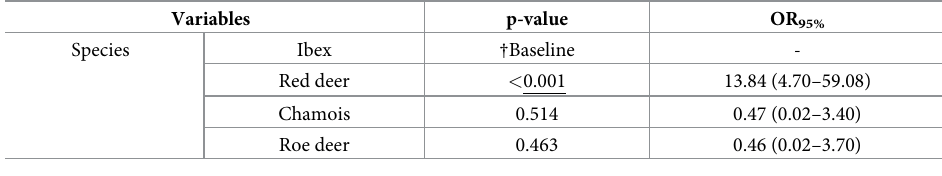
Table 4. Multivariable analysis of risk factors for infection with benign Dichelobacter nodosus in wild ungulates.